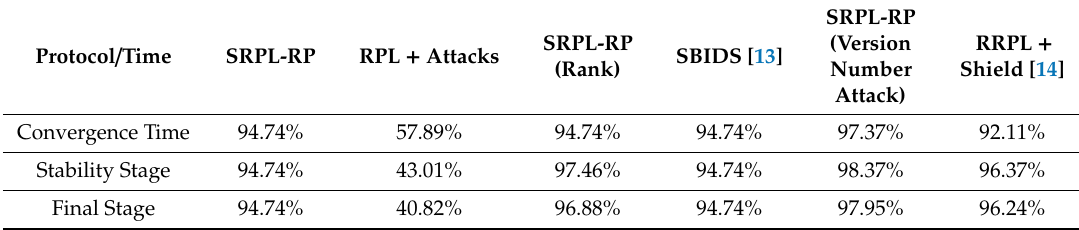
Table 5. Packet Delivery Ratio Comparison in Random